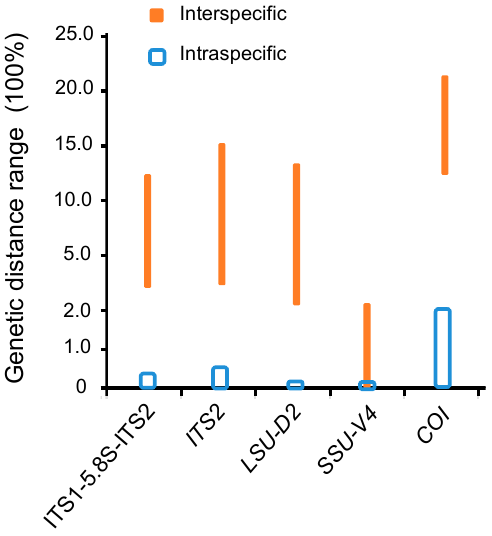
Figure 1. Genetic distance ranges of ITS1-5.8S-ITS2, ITS2, LSU-D2, SSU-V4, and COI within Pseudokeronopsis .